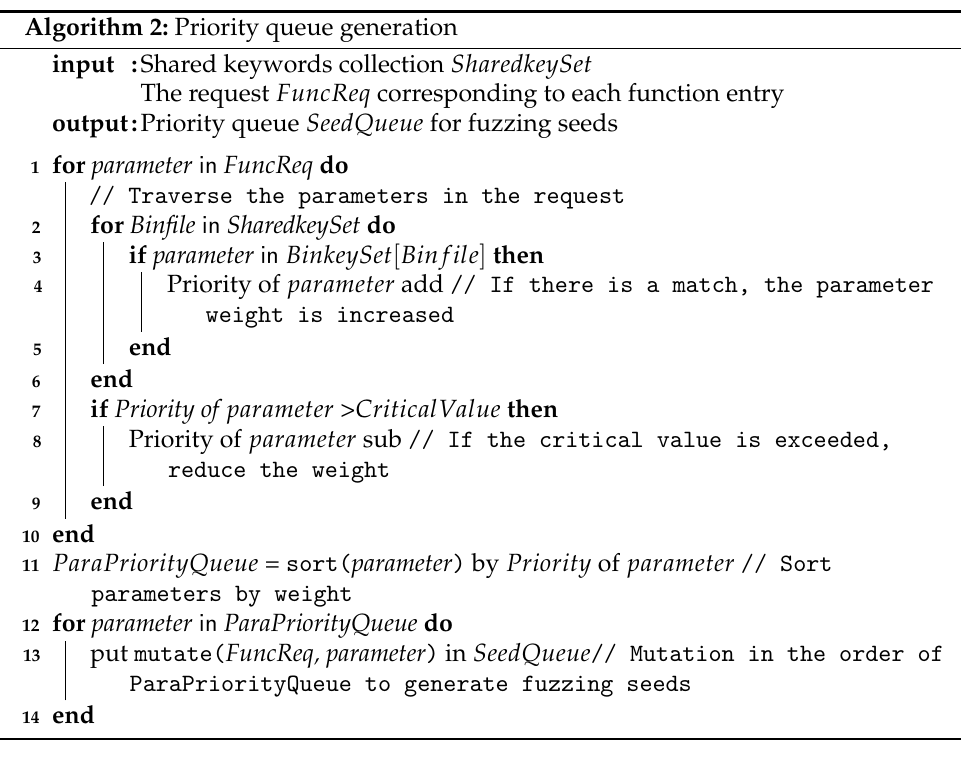
Figure 4. The set of extracted shared keywords in ASUS RT-N53